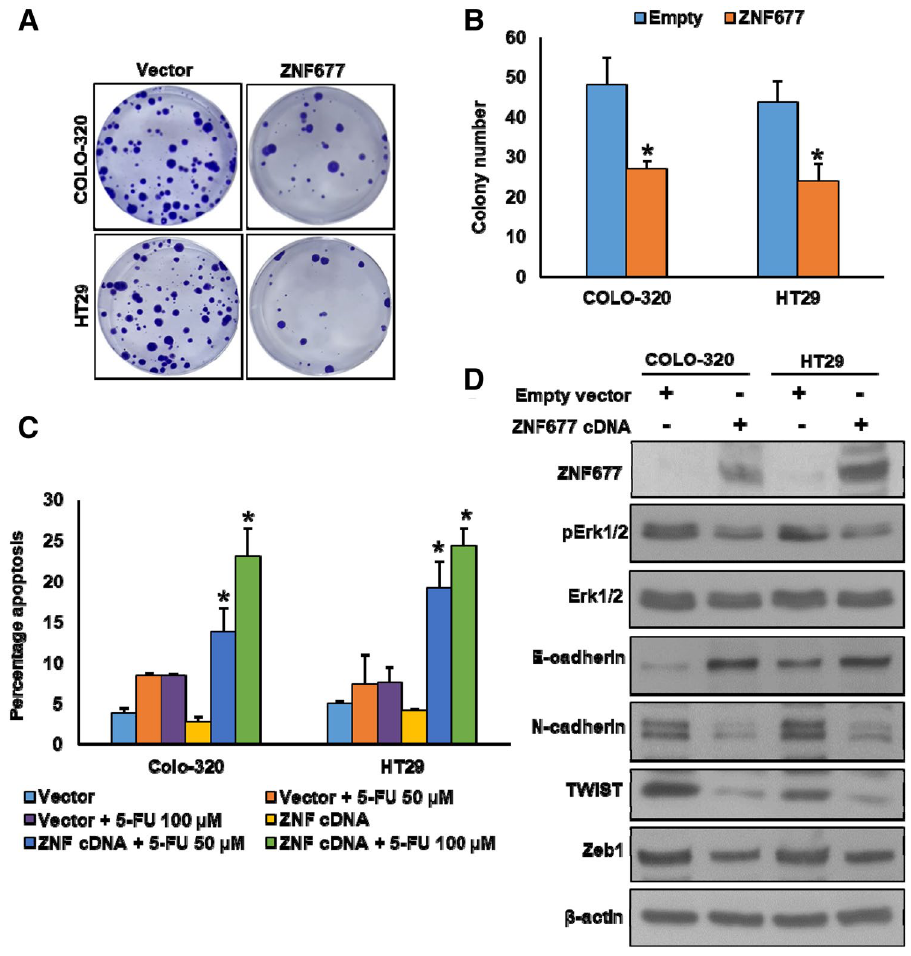
Figure 4. Ectopic expression of ZNF677 decreases the chemoresistance in CRC cell lines. ( A , B ) Overexpression of ZNF677 decreases clonogenicity. CRC cells were transfected with either empty vector or ZNF677 cDNA. After 48 h, cells were seeded at a density of 500 cells per well in 6-well plate, and grown for an additional 10 days, then stained with crystal violet and colonies were counted (n = 3), * p < 0.05, compared to control. ( C ). Overexpression of ZNF677 decreases the chemoresistance. After transfection with ZNF677 cDNA, cells were treated with 50 and 100 μM 5-fluorouracil (FU) for 48 h and analysed for apoptosis by flow cytometry (n = 3), * p < 0.05, compared to respective 5-FU alone treated control. ( D ) Overexpression of ZNF677 decrease the markers of cell survival and EMT progression. After transfection with ZNF677 cDNA, cells were immuno- blotted with antibodies against ZNF677, pERK1/2, ERK1/2, E-cadherin, N-cadherin, TWIST, Zeb1 and β-actin as